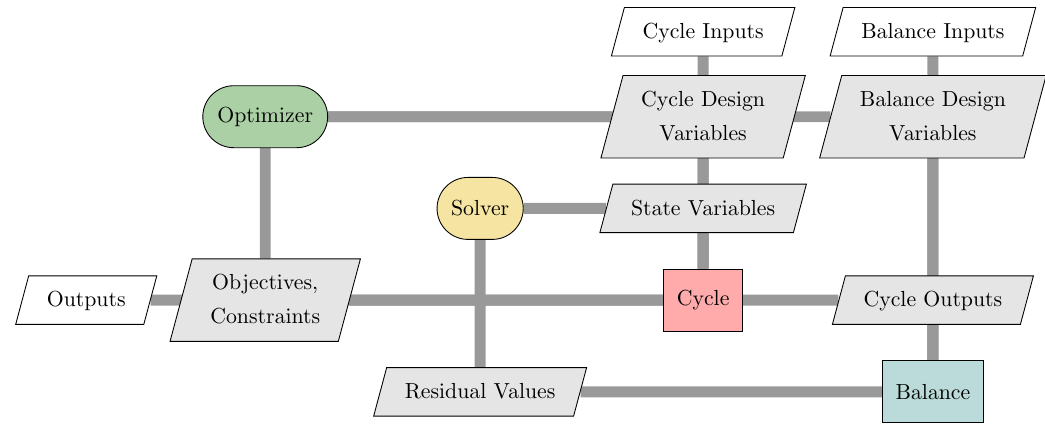
Figure 2. General cycle analysis tool